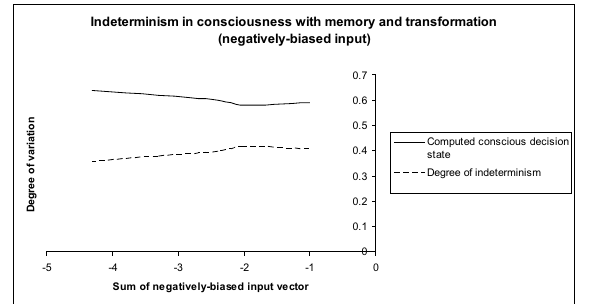
Fig. 31. Consciousness in complete memory system (transformed excitation, (cid:16) biased C2).